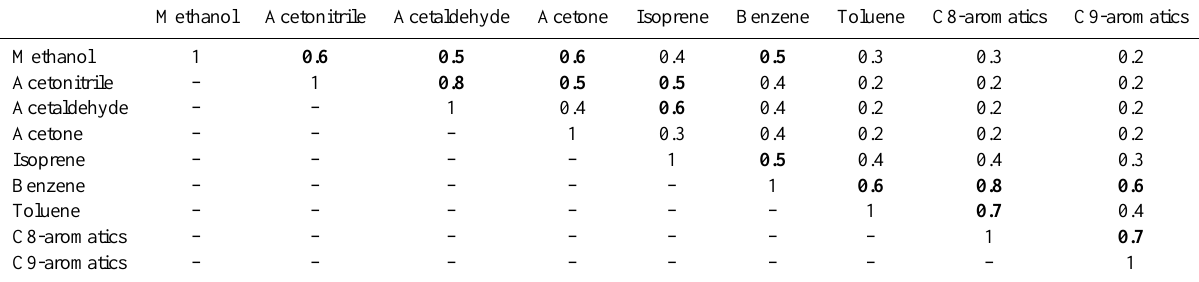
Table 5. Inter-VOC correlation analysis of nighttime data. r 2 values ≥ 0.5 are shown in